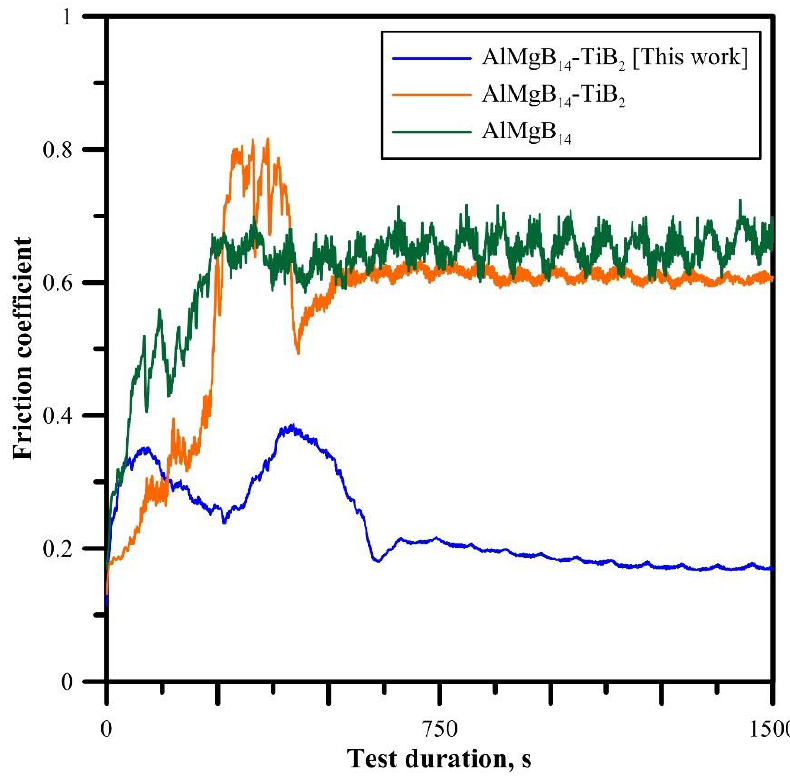
Figure 4. Friction coefficient of the obtained AlMgB 14 -TiB 2 composite under dry conditions.